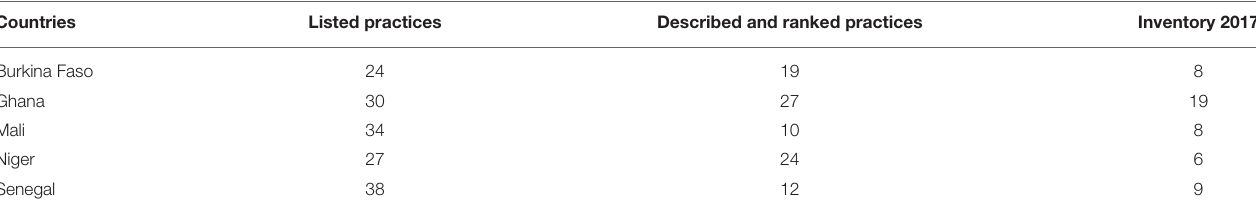
TABLE 1 | Number of practices inventoried, prioritized, and ranked in the five benchmark sites of CCAFS in West Africa: Yatenga in Burkina Faso, Lawra Jirapa in Ghana, Cinzana in Mali, Fakara in Niger, and Kaffrine in Senegal. Countries Listed practices Described and ranked